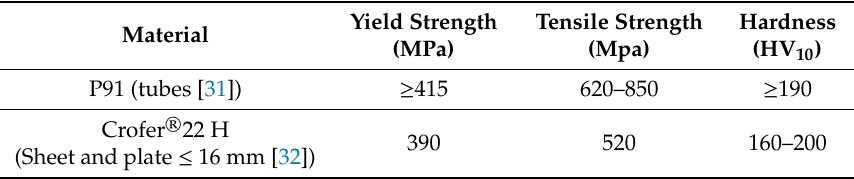
Table 2. Typical mechanical properties of P91 and Crofer ® 22 H at ambient temperature in the as- delivered state.